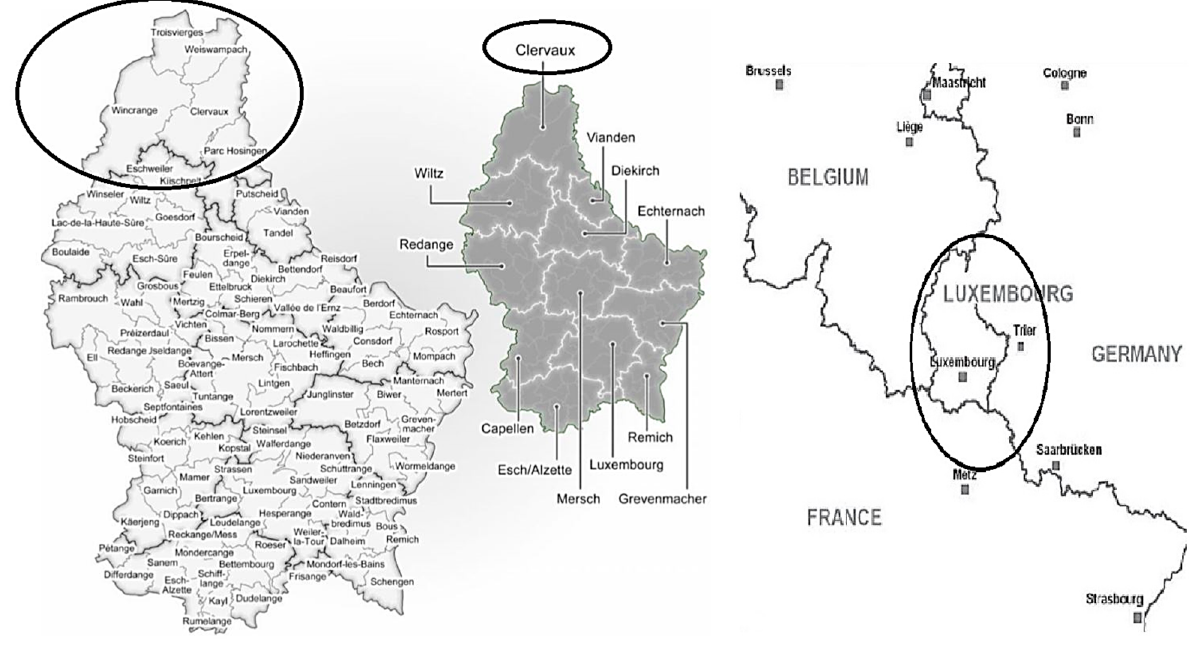
Figure 2. Canton Clervaux, situated in Luxembourg (Neises 2013; STATEC 2019a). The sociolinguistic situation in Luxembourg, including Canton Clervaux, is characterised by high degrees of multilingualism. Historically, Luxembourgish has been in contact with Standard German and French, which have occupied H(igh) domains for a longer time and more extensively than the newly standardised Luxembourgish (Gilles 2019; Horner and Weber 2008; Newton 1996). Standard German in particular acted as a structural standard variety for the Moselle Franconian speech community during the 19th and 20th century, before Standard Luxembourgish was introduced (Gilles 2019; Stell 2006; Ziegler 2012). In addition, French historically occupied functions of a standard variety and is identified as potentially contributing to the endangerment of the Moselle Franconian vernaculars (Fehlen 2016; UNESCO